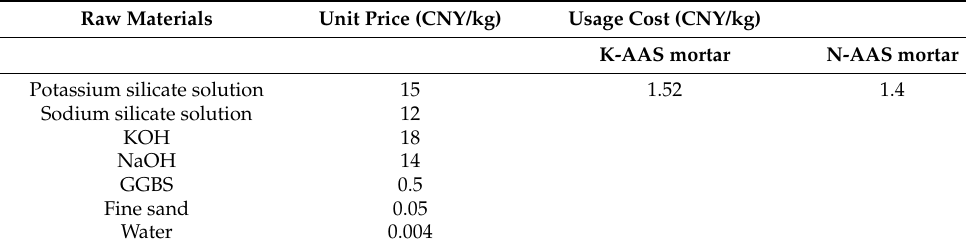
Table 4. The cost estimation of K-AAS and